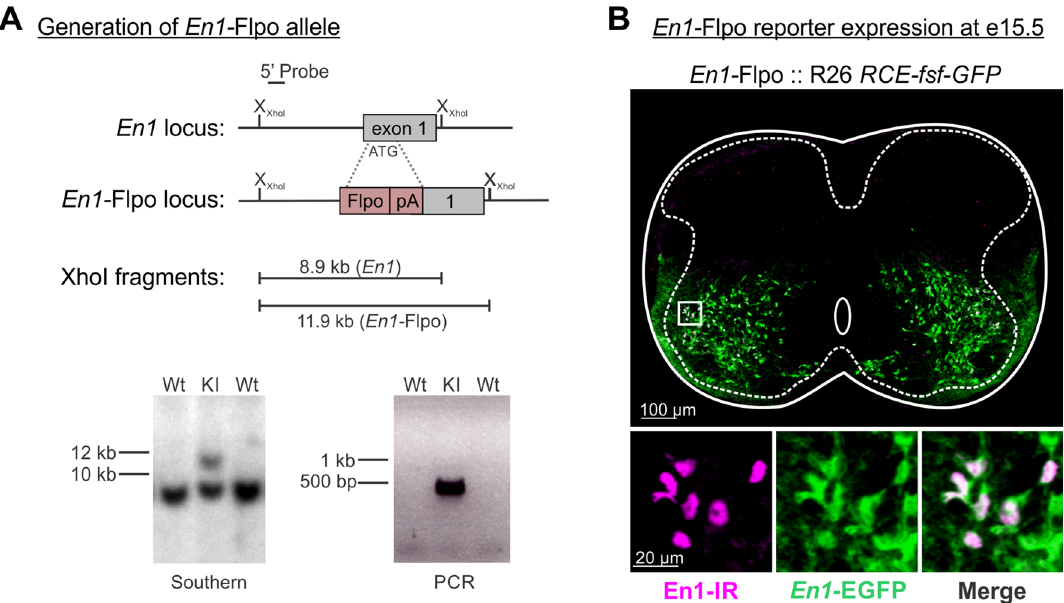
Figure 4. Generation of En1 -Flpo mice. (A) Targeting strategy to generate En1 -Flpo mice. Flpo was inserted into the ATG in the 1st exon of the En1 genomic locus. Dotted lines represent approximate regions of homology in the targeting vector. Southern blot (bottom, left) of XhoI-digested genomic DNA with a 5’ probe external to the targeting vector identifies an 8.9 kb wild-type fragment and an 11.9 kb knock-in fragment. (Not shown: Deletion of selectable neomycin resistance gene flanked by loxP sites by crossing to protamine -Cre mice, which recombines the floxed PGK-Neo cassette in the male germline). PCR analysis (bottom, right) identifies a 484 bp band in the En1::Flpo allele. Southern and PCR blot show just two examples that were cropped form larger blots. The full lab hand-annotated blots are supplied at the end of the supplementary file. ( B) En1 expression and reporter expression at e15.5. Top: low magnification confocal image stack of an e15.5 lumbar spinal cord section (20 µm thick) from a En1 -Flpo :: R26 RCE-fsf-GFP animal, demonstrating GFP expression in ventral horn interneurons (green) and colocalization with En1 immunolabeling (magenta). Bottom: En1-IR neurons with GFP in the square region indicated in the low magnification image. Note that some lineage-labeled GFP + interneurons no longer express En1 protein at e15.5, likely reflecting rapid downregulation of En1 in many postmitotic V1